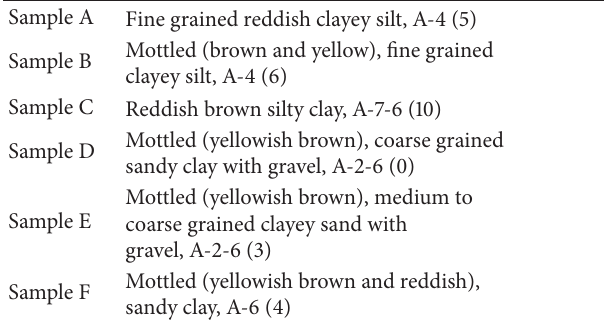
Table 4: Summary of the undrained shear strength ( 𝑆 𝑢 ) and other soil